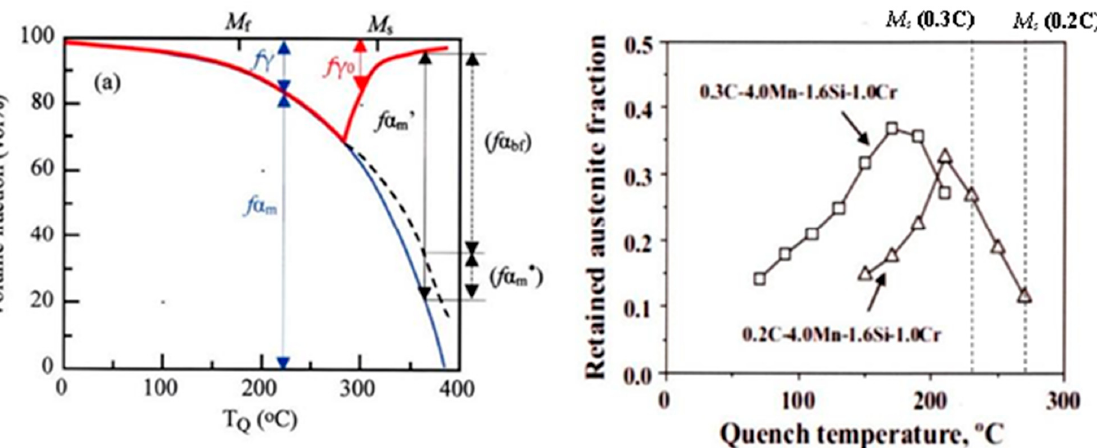
Figure 5. ( a ) Illustration of variations in volume fractions of different phases as a function of quenching temperature ( T Q ) in two-step Q&P steel. ( b ) Variations in initial retained austenite fraction with T Q in 0.2C-4.0Mn-1.6Si-1.0Cr ( M s = 273 ◦ C) and 0.3C-1.0Mn-1.6Si-1.0Cr ( M s = 235 ◦ C) two-step Q&P steels [23]. ( a ) is reproduced based on references [19,20], in which f α m and f γ are volume fractions of primary coarse soft martensite and austenite as functions of T Q prior to partitioning. The final or initial austenite fraction ( f γ 0 ) at room temperature is given by a red, bold, solid line. f α m ’ = f α bf (bainitic ferrite fraction) + f α m * (secondary fine hard martensite fraction). ( b ) is reprinted with permission from Elsevier, copyright 2022.